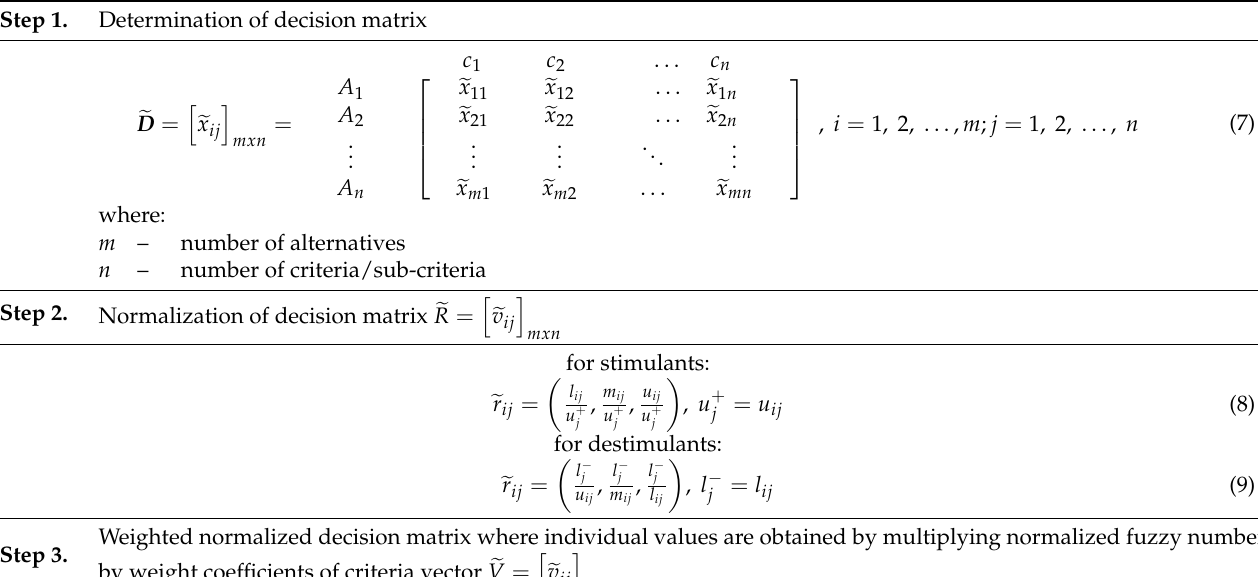
Table 5. Calculation algorithm of FuzzyTOPSIS method developed based on